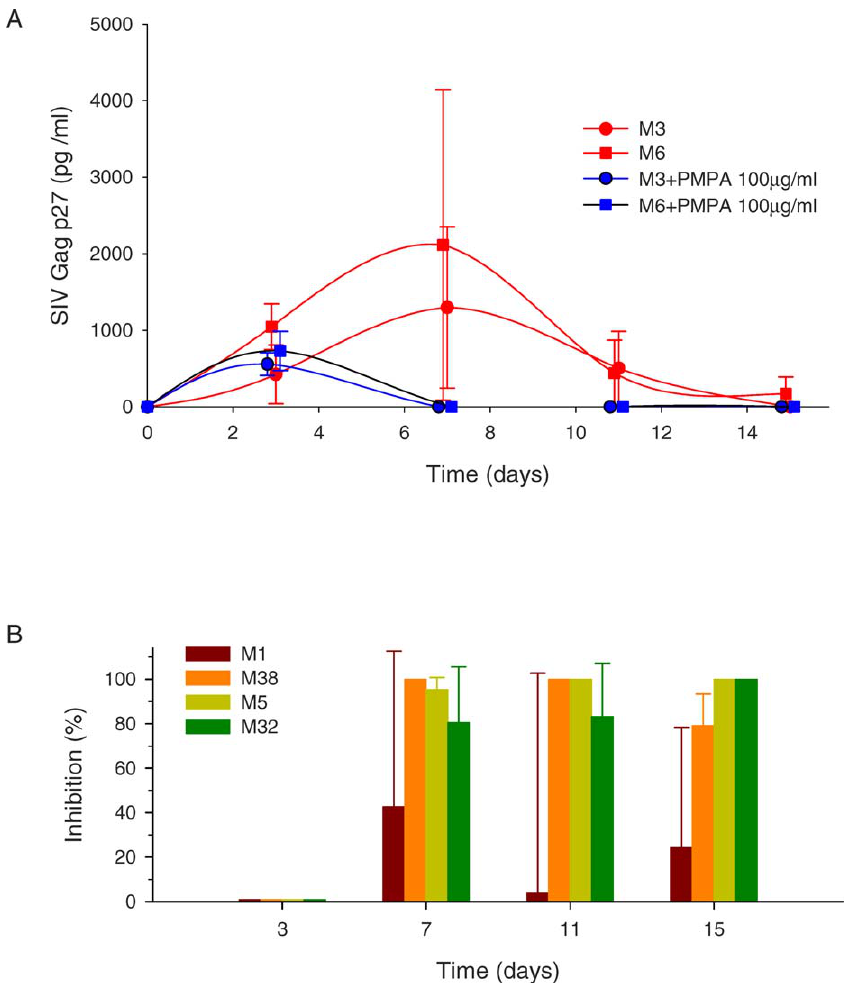
Figure 4. Colorectal Explants from Macaques Supported Replication of SIV That Was Inhibited by Pretreatment with Tenofovir In Vitro and In Vivo (A) Replication dynamics of SIVmac 251/32H in explants from two untreated animals (group F: M3, M6) in the presence or absence of exogenously added tenofovir at 100 l g/ml. A total of 10 4 TCID 50 of virus was added to each well containing three explants in a total volume of 200 l l of medium. Virus replication was assayed by SIV Gag p27 production and mean values þ / (cid:2) standard deviations are shown for four replicates of each tissue. (B) Colorectal explants from four animals (group G: M1, M38, M5, M32) dosed in vivo with tenofovir per rectum 3 h before tissue removal were exposed to virus in vitro (as described above) and culture supernatants assayed for Gag p27. Mean percent inhibition of SIV Gag p27 production plus standard deviations are